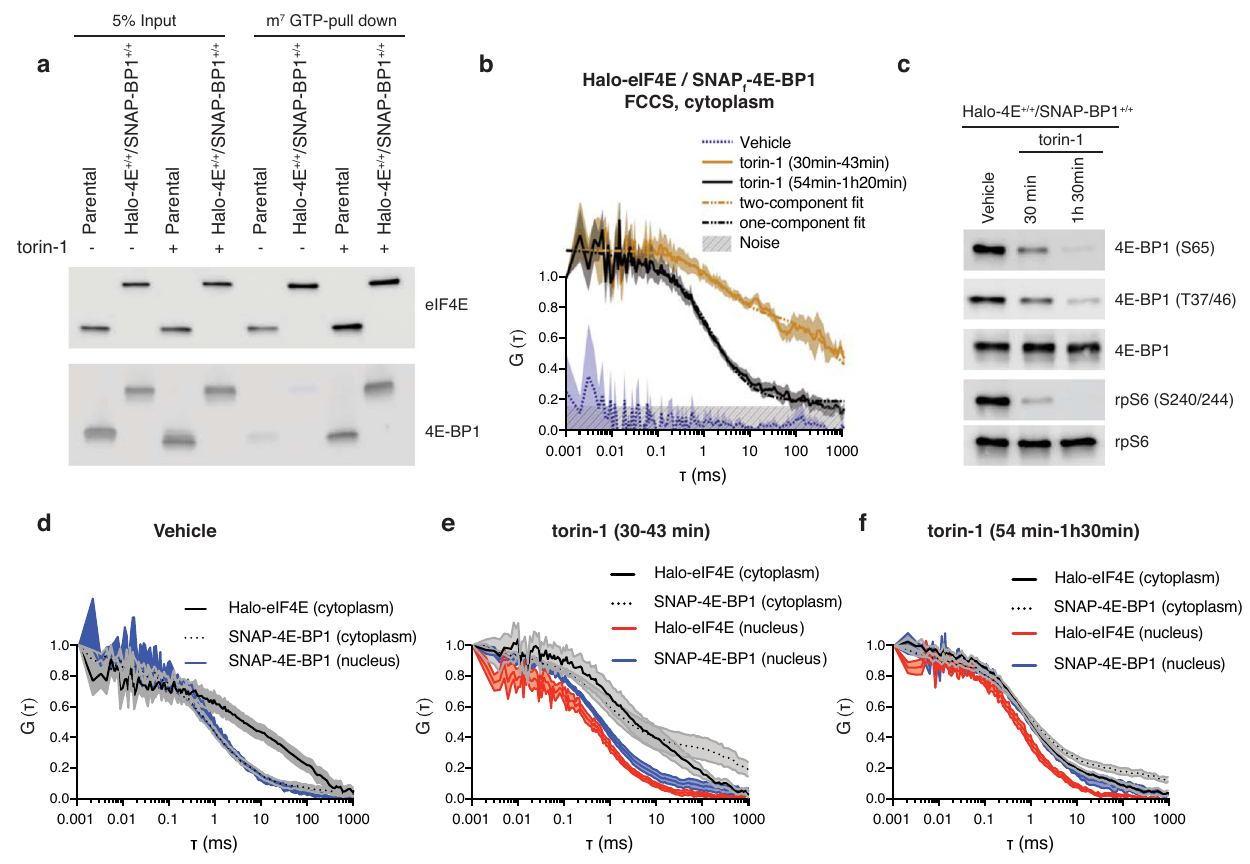
Fig.2|eIF4Eisreleasedfromthe5 ’ capuponbindingto4E-BP1.a Differentiated parental and mESC in which Halo and SNAP f tags were inserted into the EIF4E and 4EBP1 locus, respectively (Halo-4E +/+ /SNAP-BP1 +/+ ), were treated with